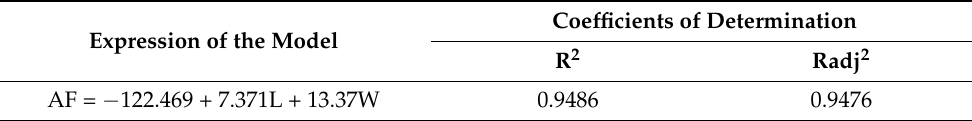
Table 2. Expression of the regression model in the estimation of leaf area.